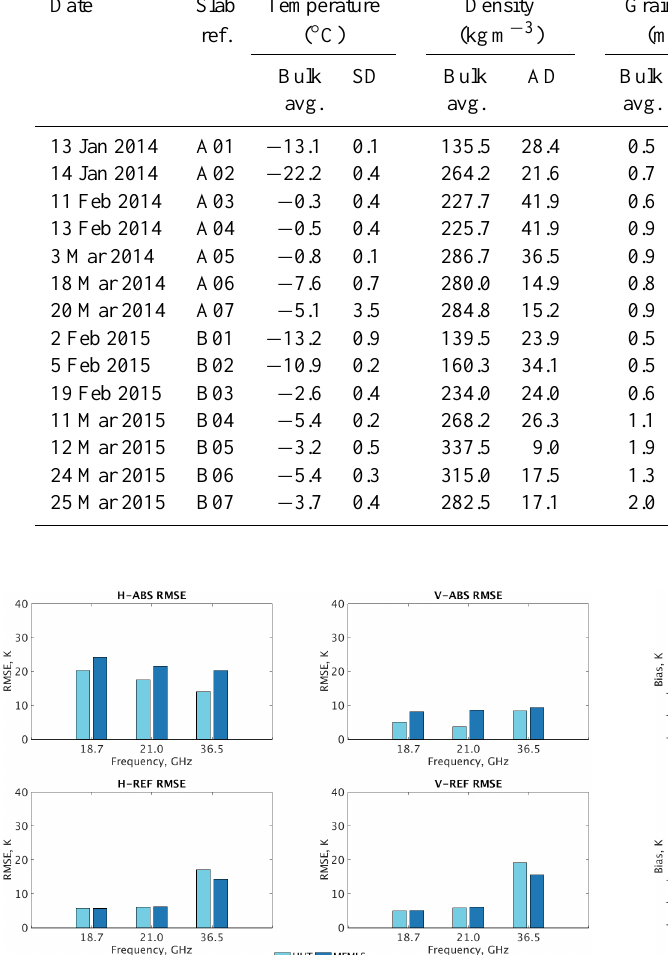
Figure 5. Simulated brightness temperature RMSE at horizon- tal (H) and vertical (V) polarizations for the absorber material base (ABS) and the reflective metal plate base (REF). Eight slabs were simulated at 18.7 and 21.0GHz, while seven slabs were simu- lated at 36.5GHz.